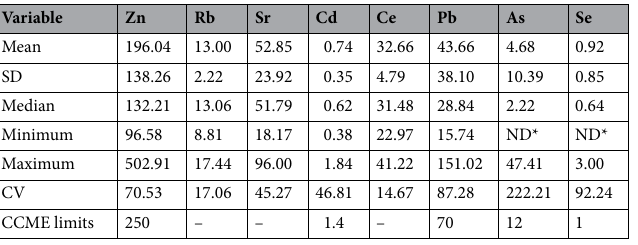
Table 1. Descriptive statistics of the soil heavy metal concentrations at 0–15 cm in Guelph community gardens (in ppm). * ND non-detectable.